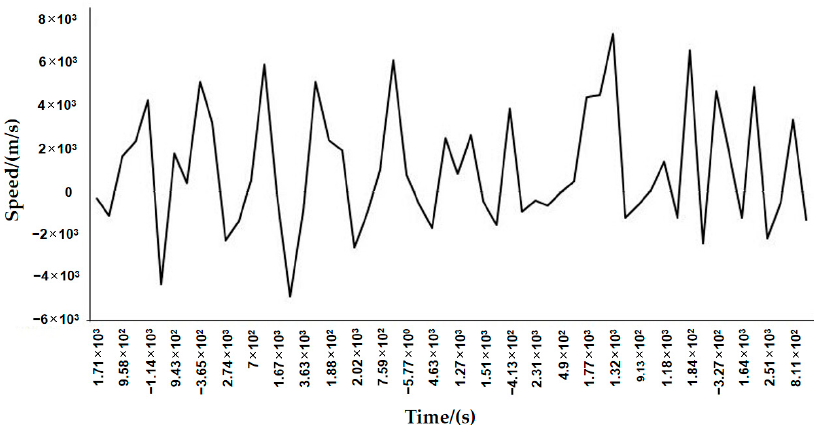
Figure 16. Velocity of link_1 in the y direction vs. time.